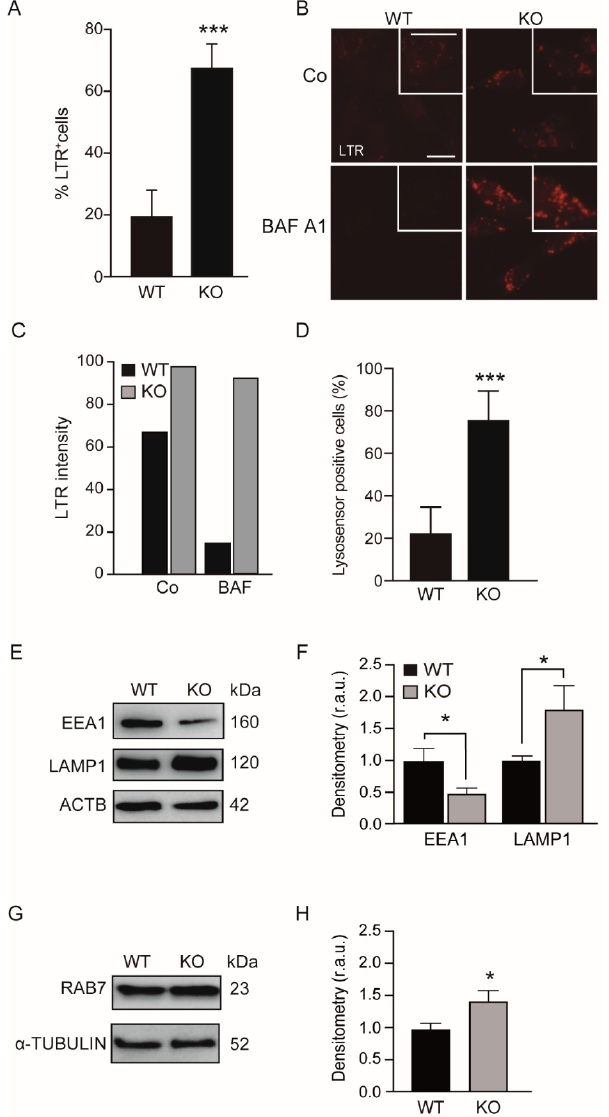
Figure 1. The loss of KEAP1 induces the accumulation of acidic vesicles. WT and Keap1 KO mouse embryonic fibroblasts (MEFs) were cultured in control conditions (Co) ( A,D – H ) or incubated with 100 nM bafilomycin (Baf. A1) for 4 h ( B , C ) and stained with LysoTracker red (LTR) ( A ) and LysoSensor ( D ) probes, as described in Section 2. Next, the cells were analyzed with flow cytometry ( A , D ) and fluorescence microscopy ( B ). Representative images show LTR-positive cells, (*** p < 0.001 vs. WT cells) ( B ) and the LTR intensity was quantified as shown in ( C ). The scale bar represents 10 µ m. (D ) The graph shows the percentage of LysoSensor-positive cells (*** p < 0.001 vs. WT cells). ( E , G ) Cell lysates from WT and Keap1 KO MEFs were analyzed by Western blot using anti-EEA1, RAB7 and LAMP1 antibodies. α -tubulin and ACTB were used as a loading control. ( F , H ) Densitometry was employed to quantify the abundance of EEA1 and LAMP1 normalized to ACTB ( F ) and RAB7 normalized to α -tubulin ( H ) (* p < 0.05). All data are the means ± SD of at least three independent experiments and they were analyzed using Student’s t -test. r.a.u, relative arbitrary